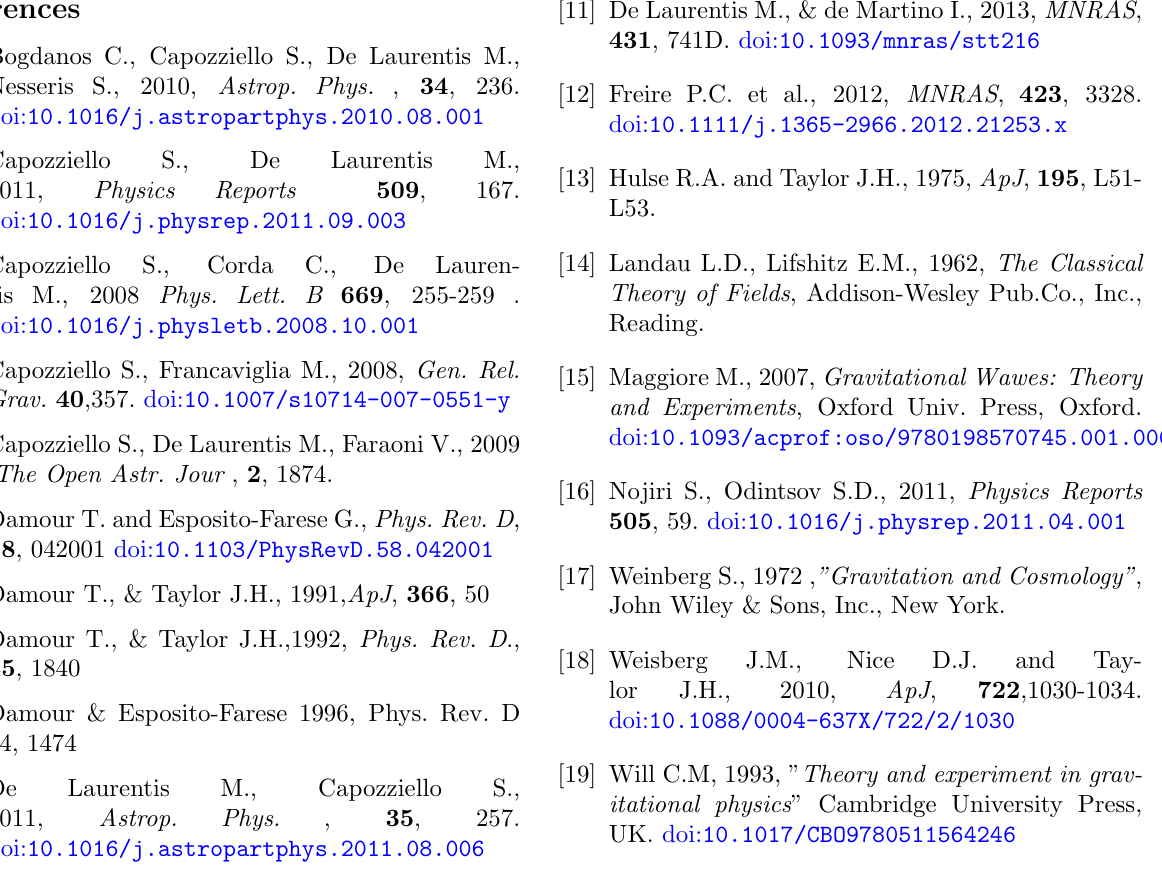
0 is tiny, indeed we Obs